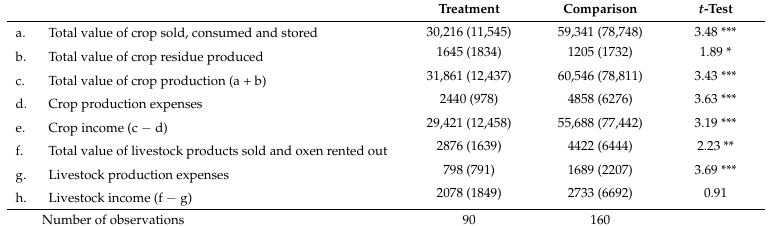
Table 1. Average value (birr) of crop and livestock income in treatment and comparison